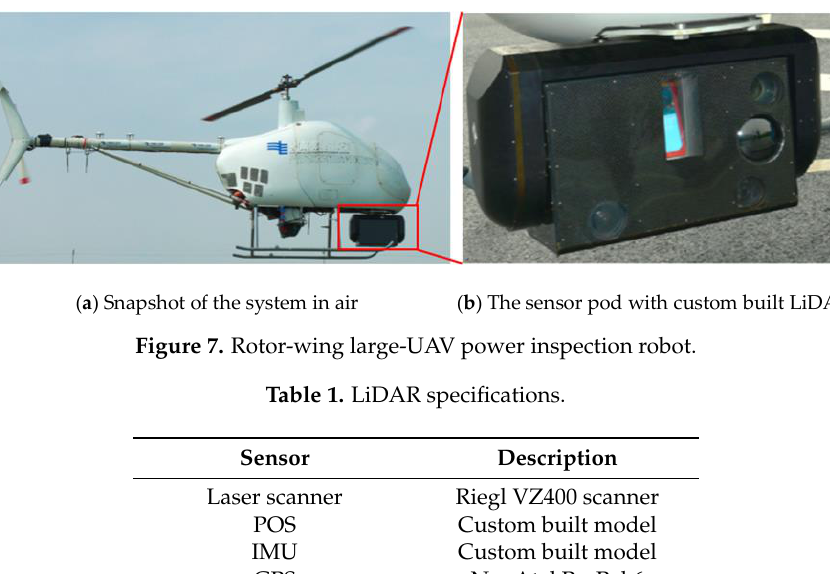
Table 2. Post-processed accuracy specifications of the custom built POS.